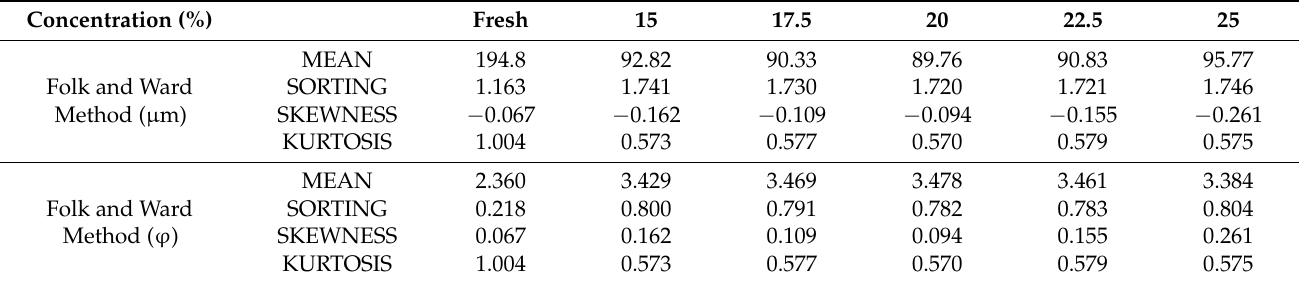
Table 6. Corundum grains distribution statistics.